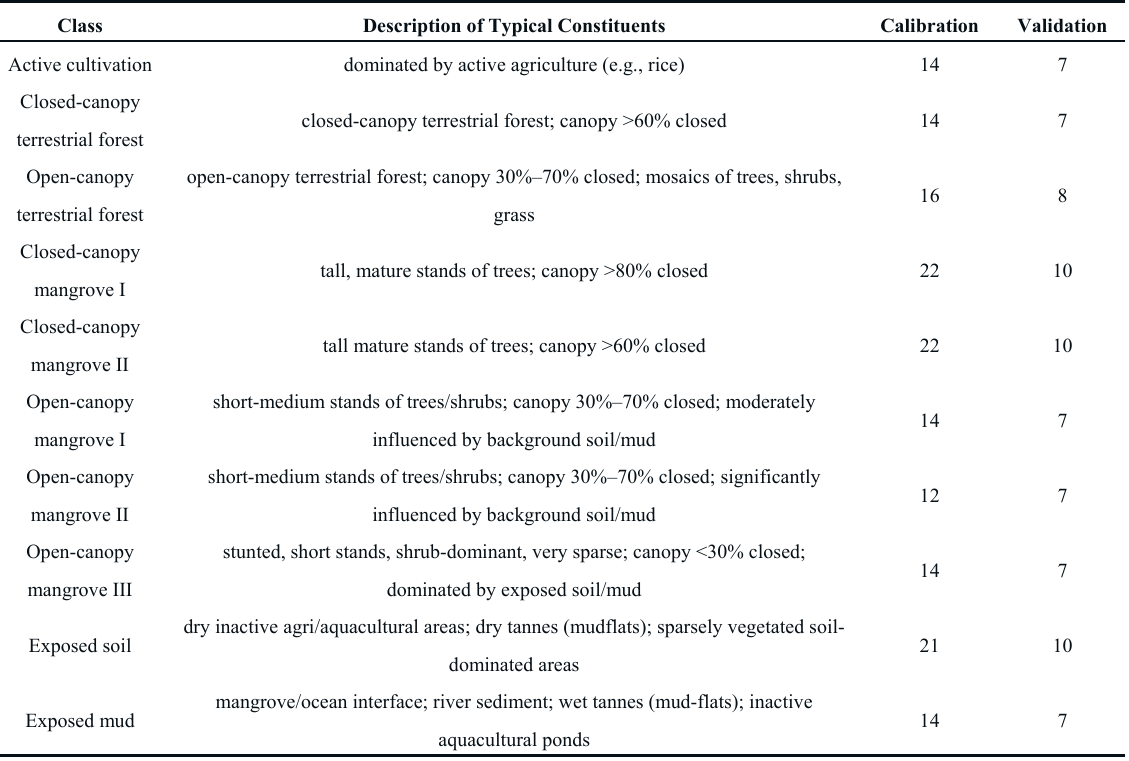
Table 1. Mapped classes and descriptions, per-class calibration, and validation reference